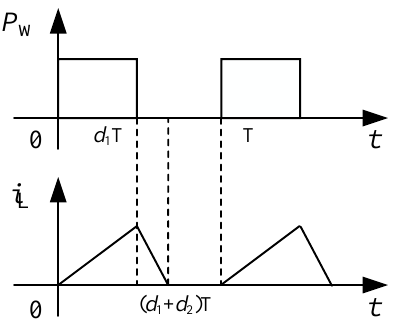
Figure 2. The inductor current waveform in the inductor current discontinuous mode. The expressions of FO inductive voltage u L and FO capacitive current i C are, respec- tively, that the inductance order is α , and the capacitance order is β : L L There are three working modes while the converter is in DCM